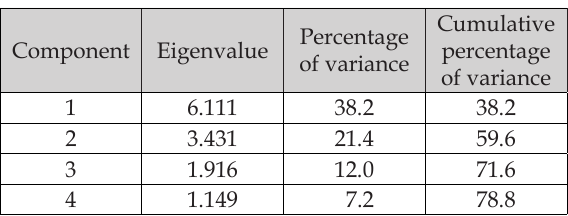
Table 1. Eigenvalues, variance percentages and cu- mulative